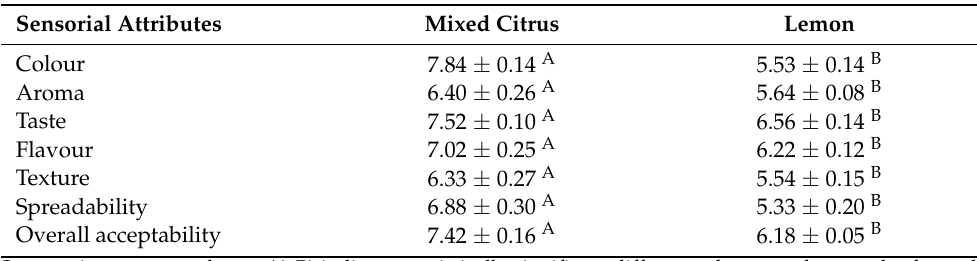
Table 8. Average scores and standard deviations for the different sensorial attributes of the sensorial analysis performed on the Lemon and Mixed Citrus